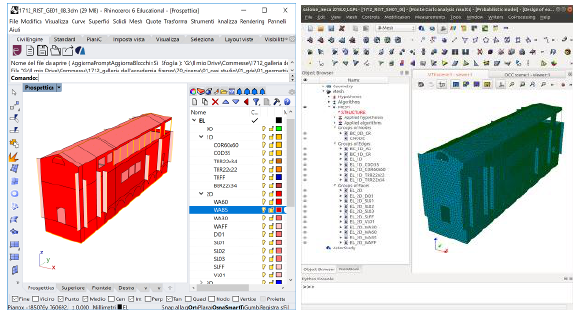
Figure 2. Transformation of the model in the BIM, geometric and FEM environment.